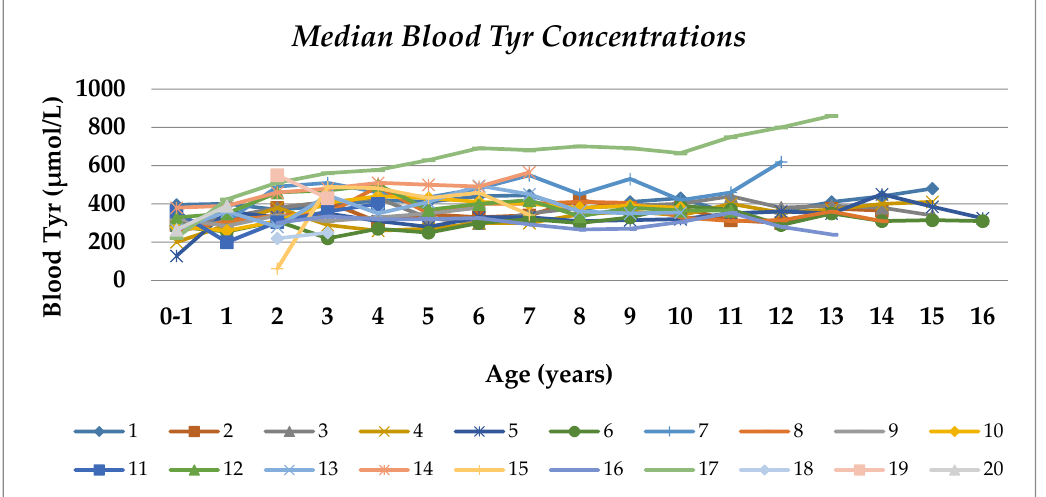
Figure 2. Median blood Phe concentrations by age in patients with HTI. Coloured lines represent individual patients.